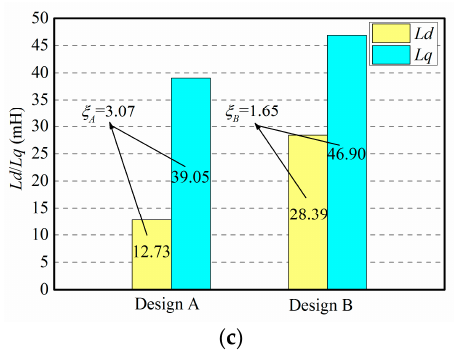
Figure 11. Torque behaviors and inductances at rated point: ( a ) Torque waveforms; ( b ) Reluctance and magnet torque; ( c ) d / q inductance.